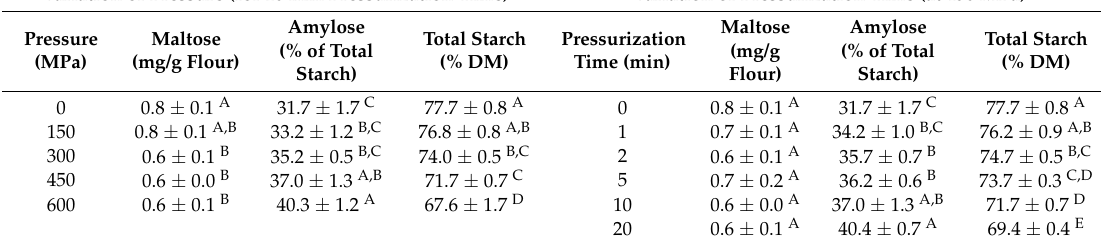
Table 2. Molecular modification of starch in wheat flour visualized by the maltose content, amylose content, and total starch content in dependency of pressurization time and pressure, x ± SD, n = 3, DM: dry